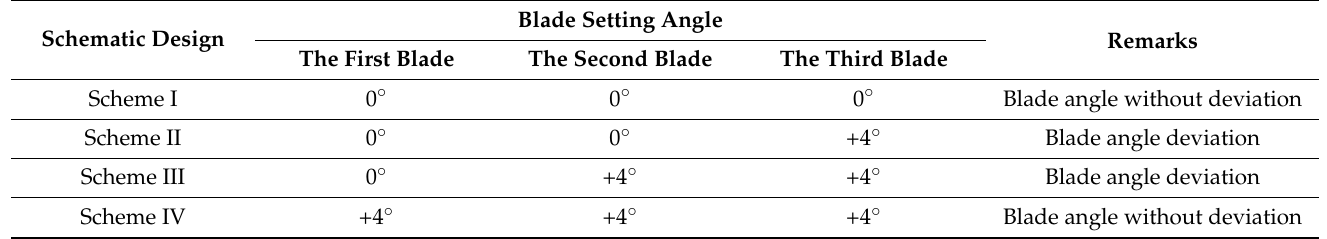
Table 2. Calculation scheme design